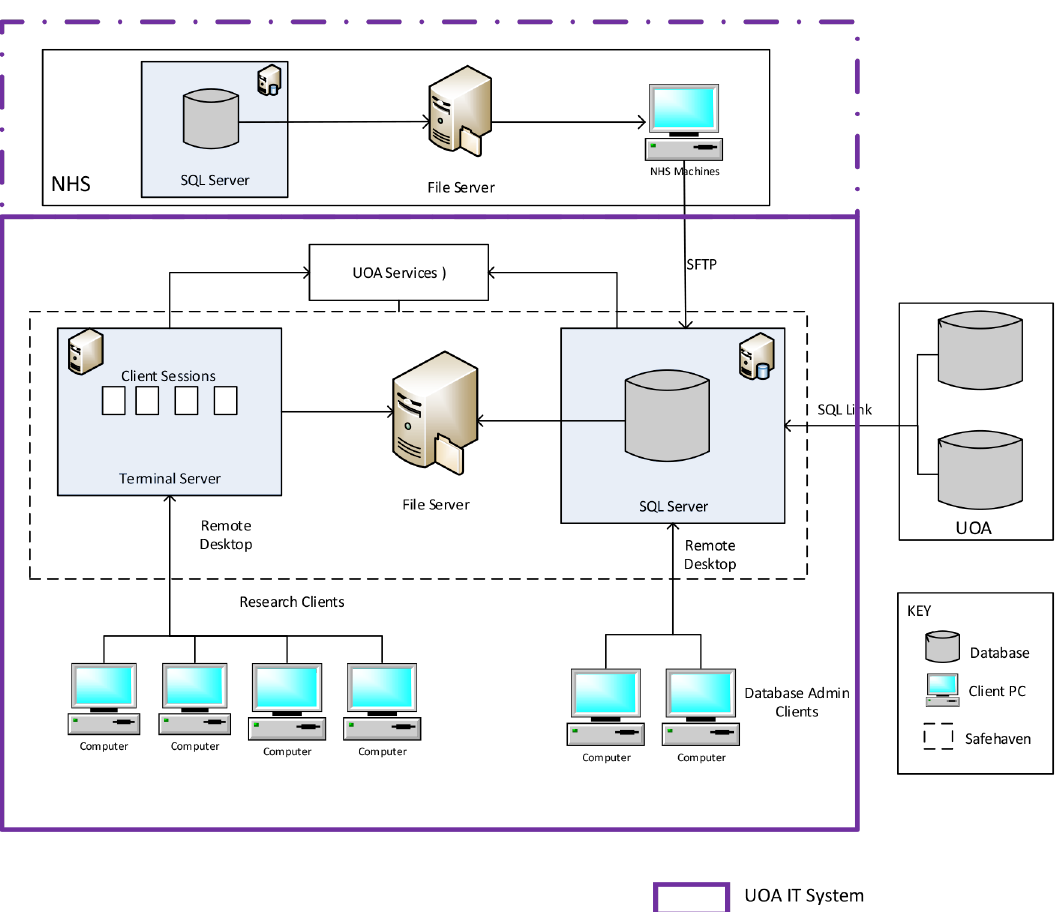
Figure 1: The Grampian DaSH